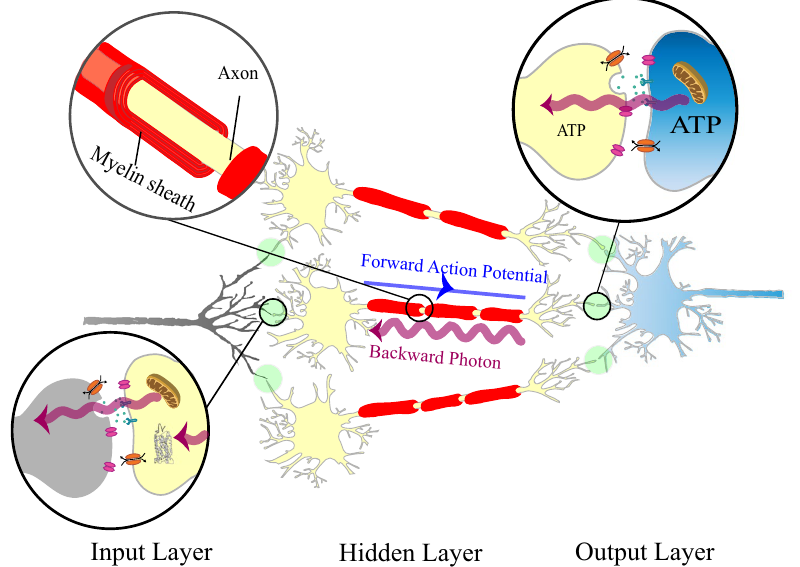
Figure 1. Schematic of a simplified network of neurons trained by backpropagation with stochastic photonic feedback. Three sets of neurons are represented as input, hidden, and output layers. For clarity, three neurons are shown in the hidden layer here. Connection of the dendrite of the post-synaptic neuron blue and the axonal terminal of the pre-synaptic neuron yellow at the synaptic cleft is enlarged (top-right, enlarged). The strength of the synapse (or synaptic weight) is greater as the result of more working ion channels (orange oval-shaped gates) in the post-synaptic neuron 46 . This is in accordance with the greater amount of ATP (adenosine triphosphate, the energy carrier molecules) usage in the post-synaptic neuron 47 . That results in more biophoton production by the post-synaptic mitochondria which can transfer backward information to the pre-synaptic neuron. The myelinated axon (top-left, enlarged) can guide the received backward photons along the axon. These biophotons might be later absorbed by opsin molecules in the brain 40,48 (bottom-left, enlarged, gray molecules in the yellow neuron) which might trigger the emission of further biophotons, thus relaying the backward information across the network (see also main